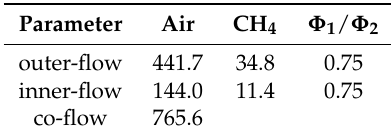
Figure 10. Top-view sketch of the Cambridge–Sandia stratified burner, dimensions in mm. Table 1. Flow rates (in SLPM) and equivalence rations of the Cambridge–Sandia stratified burner for the SwB1 non swirling operating